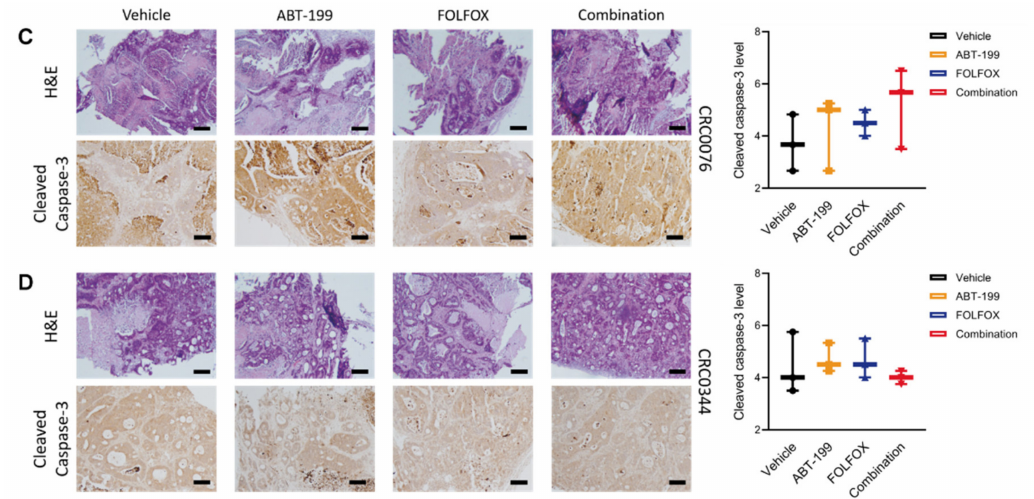
Figure 3. Decrease in p53 upregulated modulator of apoptosis (PUMA) levels but no e ff ect on BCL2-Interacting Mediator of cell death (BIM) or cleaved caspase-3, following ABT-199 treatment in CRC0076 PDX model. ( A , B ) Western blot analysis comparing the levels of PUMA and BIM in CRC0076 ( A ) and CRC0344 ( B ) PDX models. β -actin or glyceraldehyde 3-phosphate dehydrogenase (GAPDH) (see Figure S4) were used as loading controls. Error bars represent mean +/ − 2 SD, * p ≤ 0.05 (ANOVA, Tukey post-hoc). ( C , D ) Analysis of cleaved caspase-3 levels in CRC0076 ( C ) and CRC0344 ( D ) PDX models. Representative images of H&E (magnification 10 × , scale bar 100 µ m) and cleaved